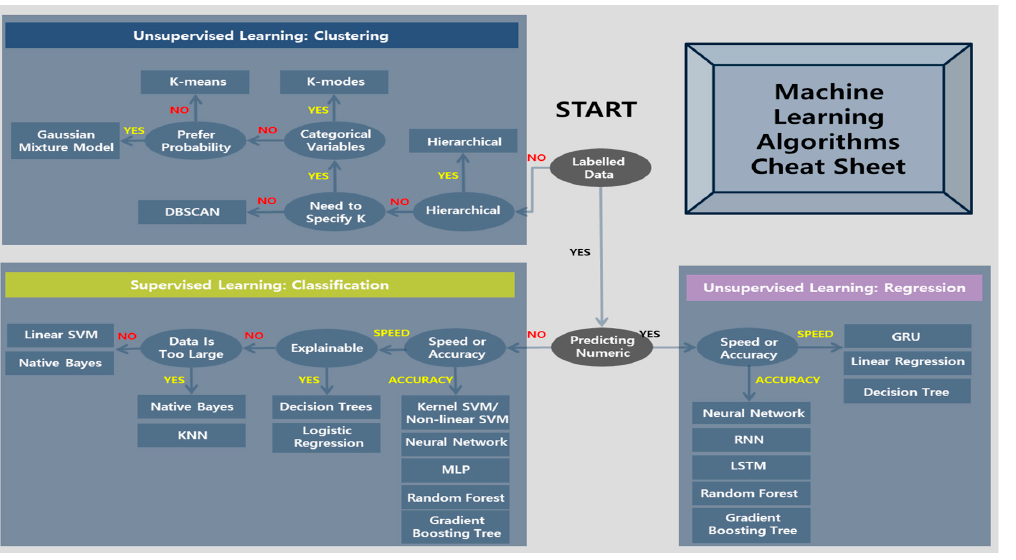
Figure 6. The machine learning algorithms cheat sheet to find the appropriate algorithms.